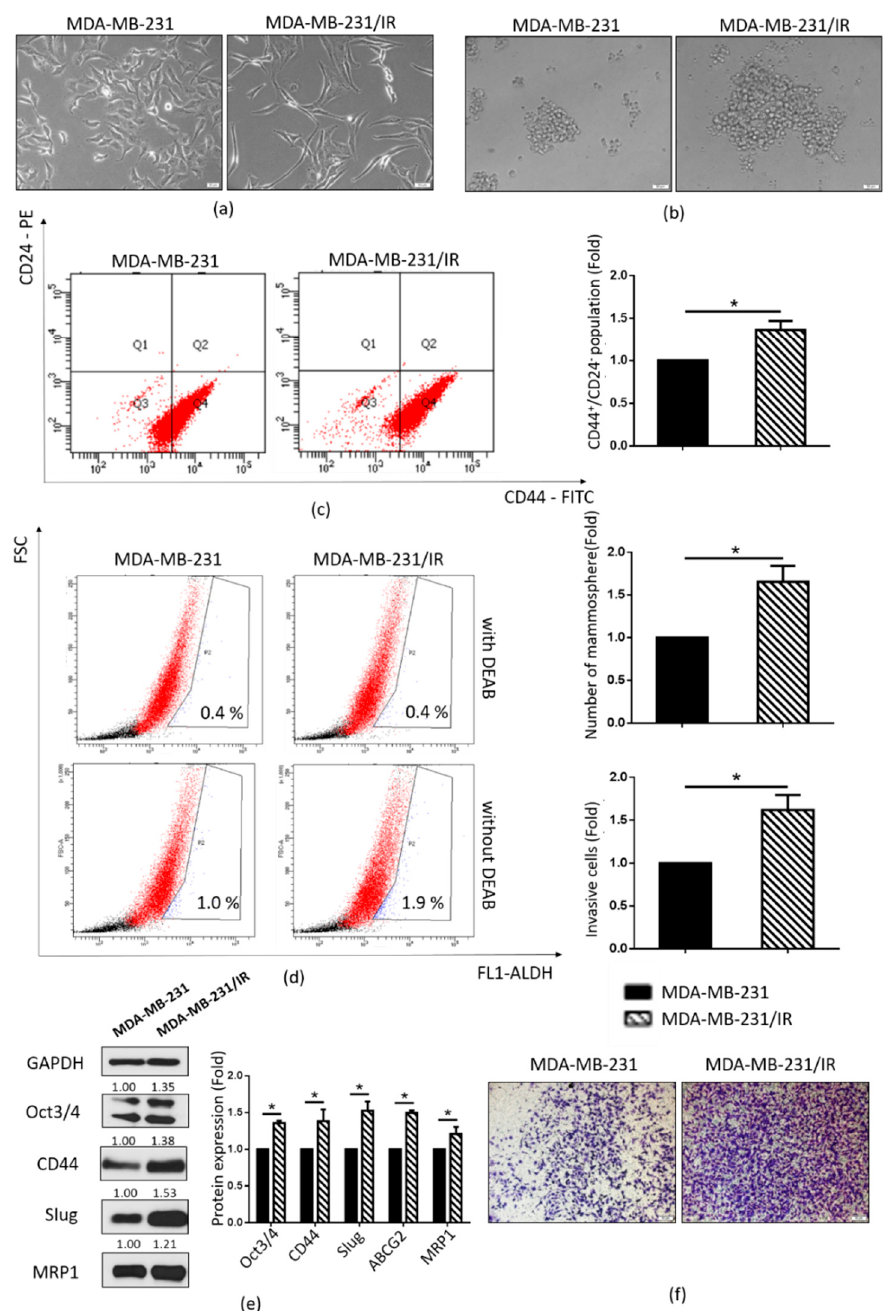
Figure 1. Characteristics of radioresistant MDA-MB-231/IR cells. ( a ) Morphologies of MDA-MB-231 and MDA-MB-231/IR cells cultured as monolayers (100× magnification). ( b ) MDA-MB-231 and MDA-MB-231/IR cells cultured as mammospheres in complete MammoCult Human Medium for 10 days (100× magnification). ( c ) CD44 + /CD24 − population in MDA-MB-231/IR and MDA-MB-231 cells as analyzed by fluorescence-activated cell sorting (FACS). ( d ) ALDH + population assessed by the ALDEFLUOR assay kit, with DEAB used as the negative control. ( e ) Cancer stem cell (CSC) markers were analyzed by Western blotting; * p < 0.05; results are presented as the mean ± standard deviation. ( f ) Invasion of MDA-MB-231/IR and MDA-MB-231 cells assessed by the Transwell cell invasion assay (100× magnification).